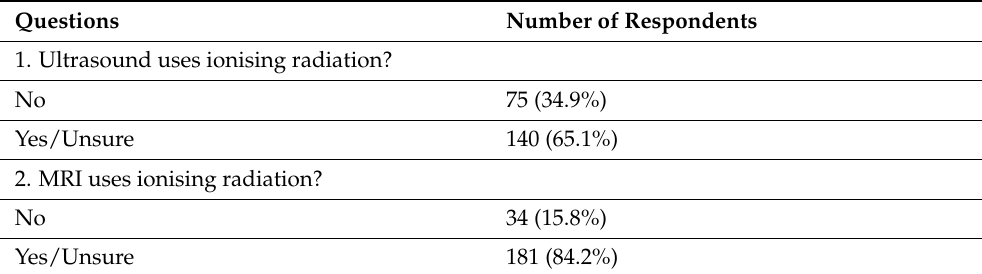
Table 3. Questionnaire responses on dose-saving medical imaging, namely ultrasound and MRI. More than 50% of the respondents did not realise these modalities are not associated with ionising radiation.